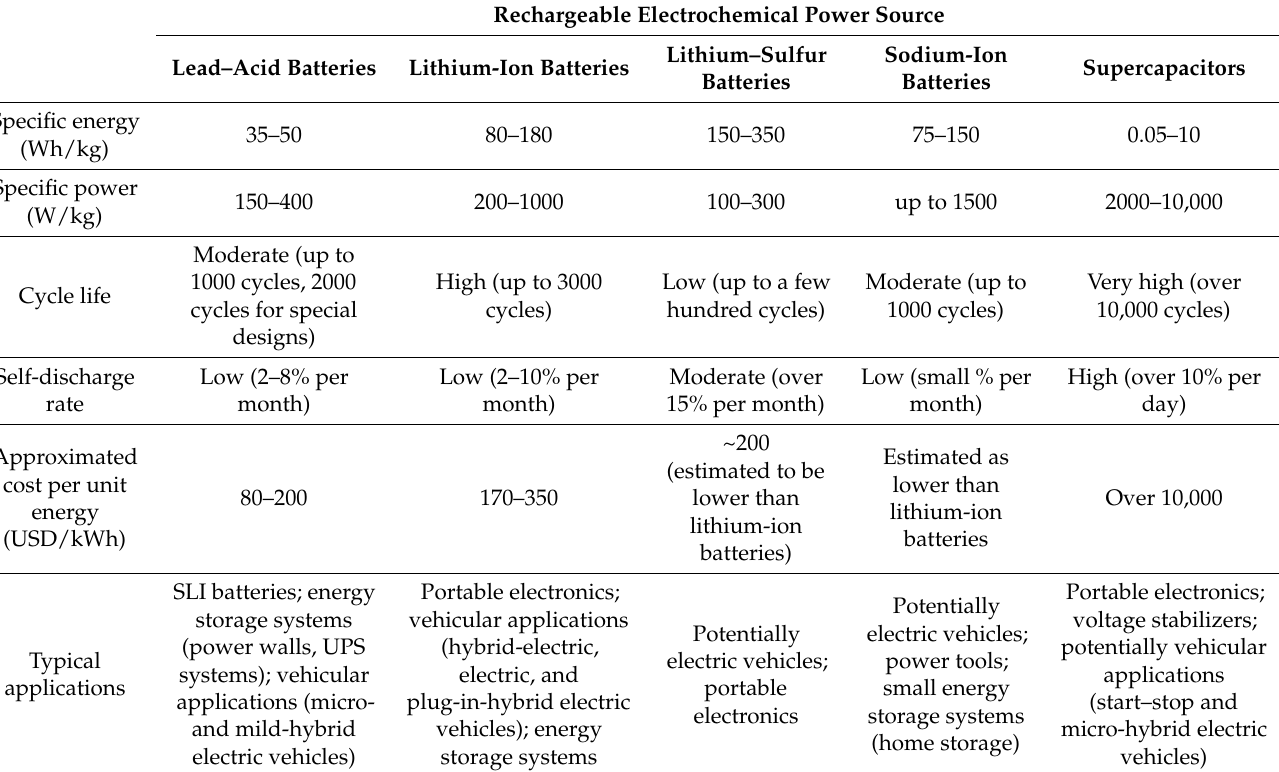
Table 1. Comparison of different rechargeable electrochemical power sources